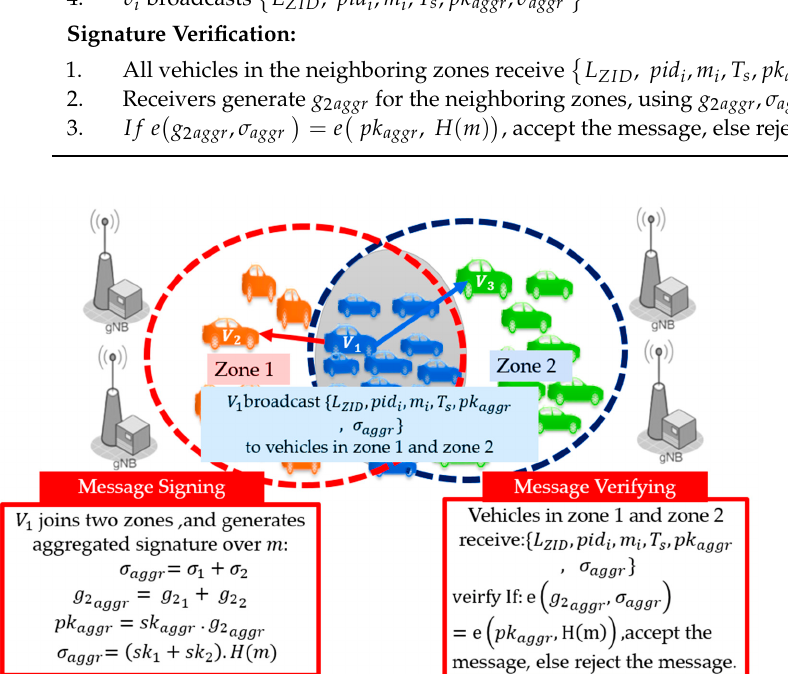
Figure 9. Multi-zone authentication using Receiver-Centric Authentication (RCA) method.